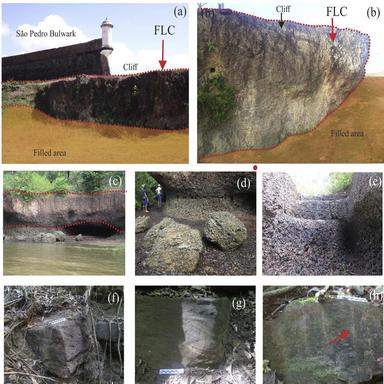
Provenance areas of FSJM rocks: FLC from the fortress implantation site (a, b) and Santana Island (c, d, e); FSS from the quarries on the banks of the Pedreira River where blocks cut at angles similar to that FSJM are seen (f, g) including with manual cutting tools (h).